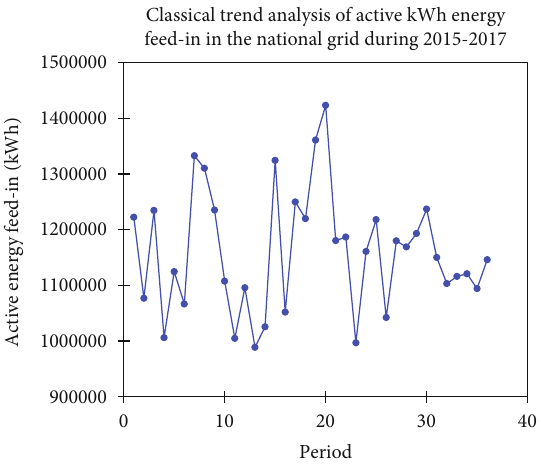
Figure 6: Classical Mann-Kendall Trend Test analysis of active kWh energy feed-in in the national grid during 2015-2017.